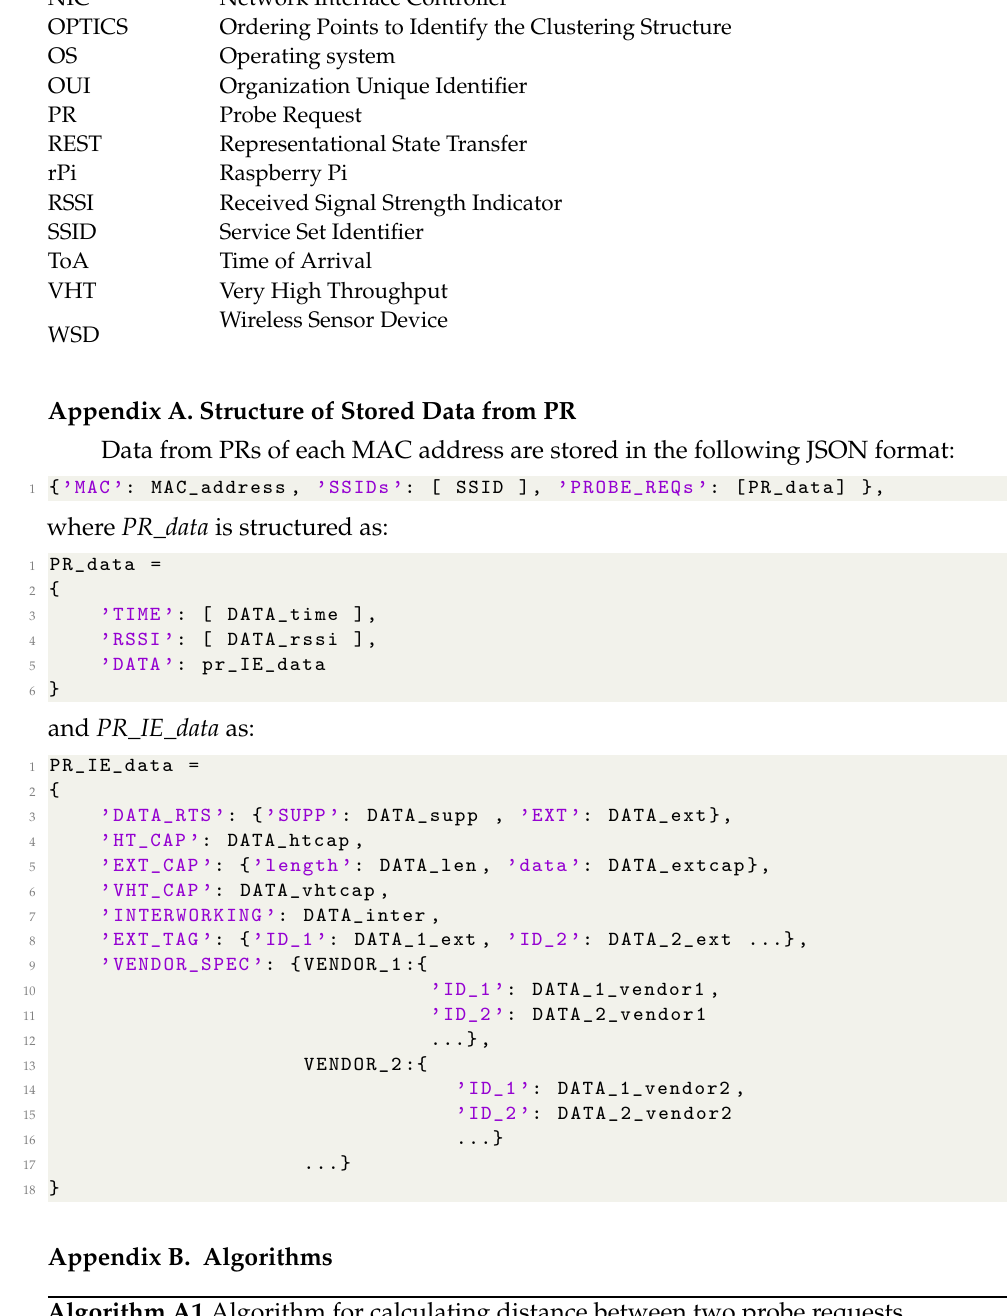
Algorithm A1 Algorithm for calculating distance between two probe